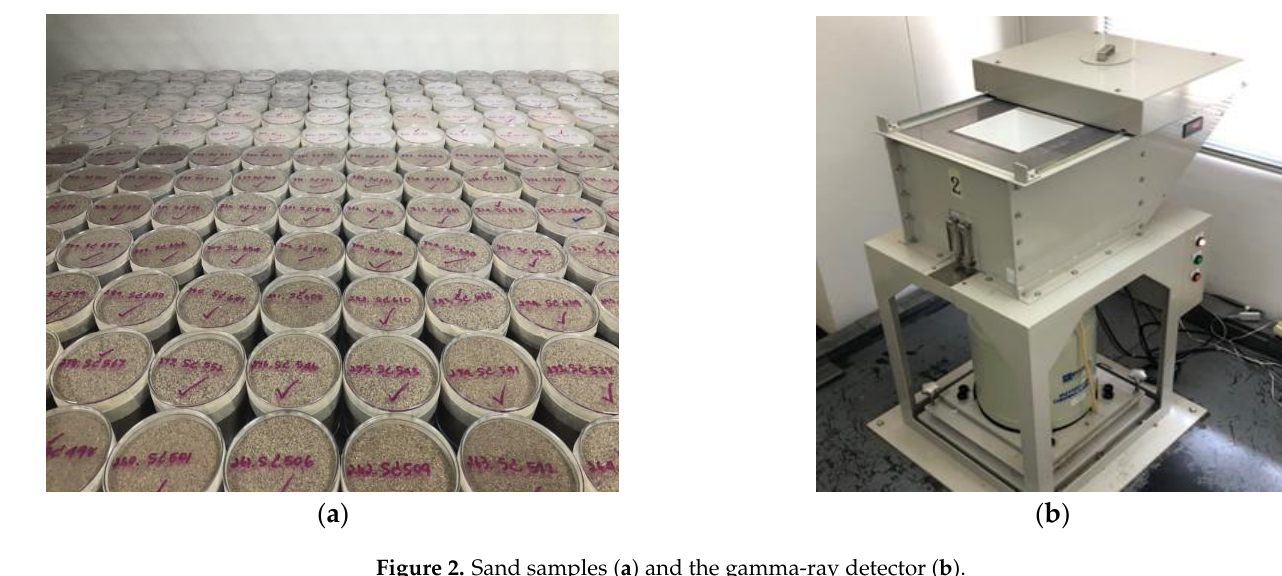
Figure 1. Study areas include Loei, Nong Bua Lam Phu, Khon Kaen, Nakhon Ratchasima, Nong Khai, Bueng Kan, and Sakon Nakhon provinces of Thailand. The unit for latitude and longitude is degree (°).